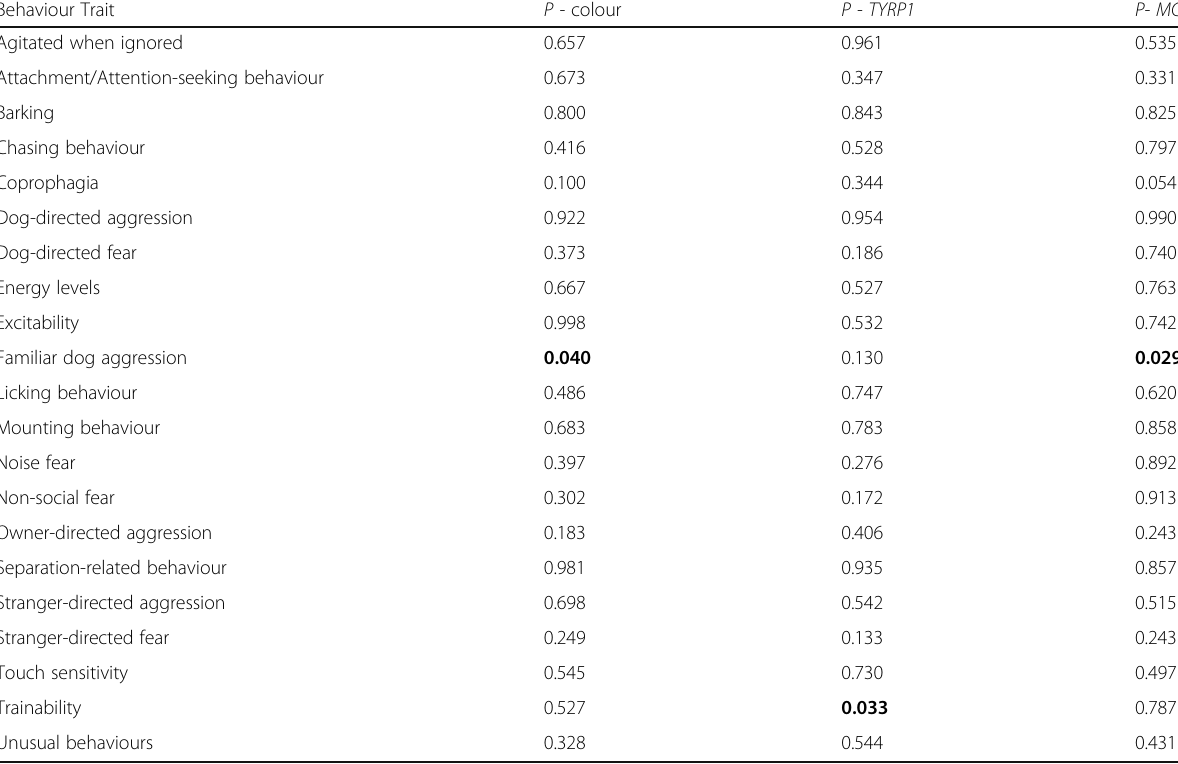
Table 3 Comparing scores for 21 behavioural traits in 63 genotyped Labrador retrievers using Kruskal-Wallis nonparametric test Behaviour Trait